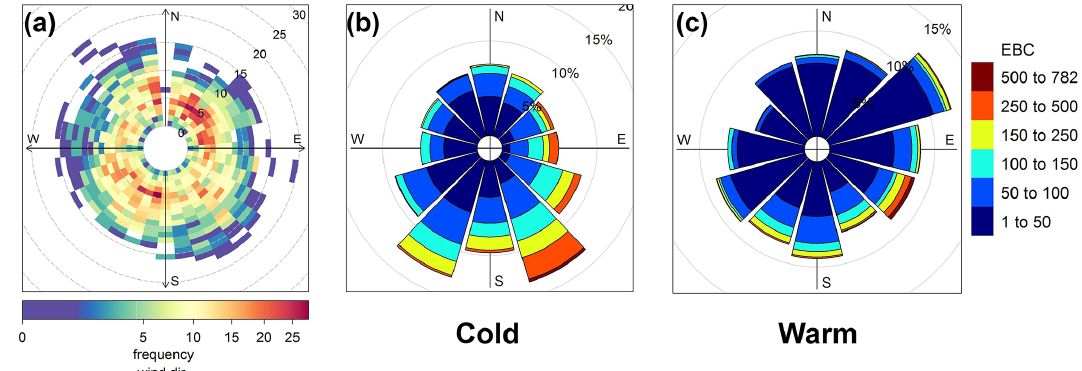
Figure 3. (a) Polar frequency plots of wind speed and direction. Each cell gives the total number of hours the wind was originating from a certain wind direction. The dashed circular grey lines show the wind speed (in ms − 1 ). Rose diagrams show EBC concentrations during the cold (b) and warm (c)